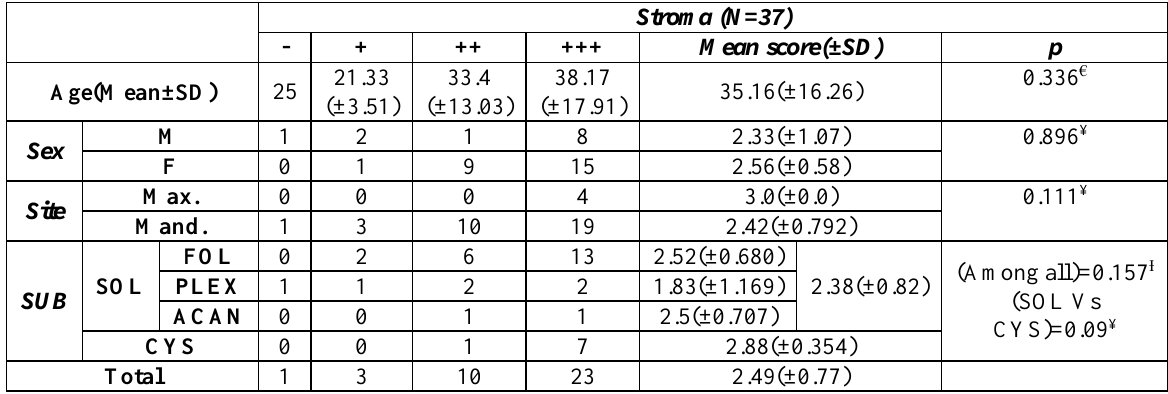
Table 3: Mean scores of endocan expression in stromal parts of ameloblastoma against age, sex, site and